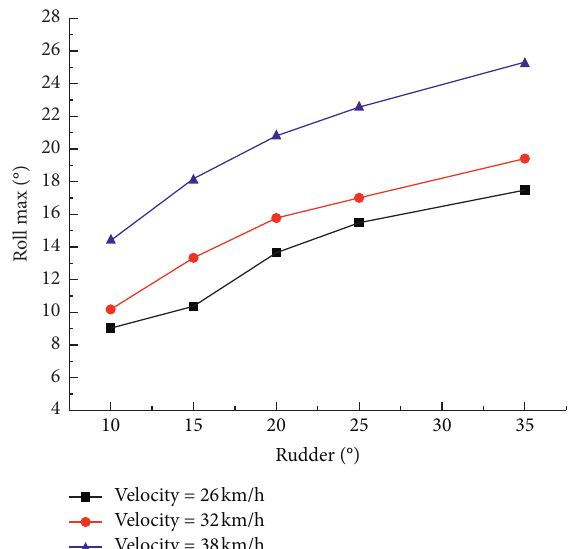
Figure 16: Maximum roll angle at 500m with respect to the rudder angle.